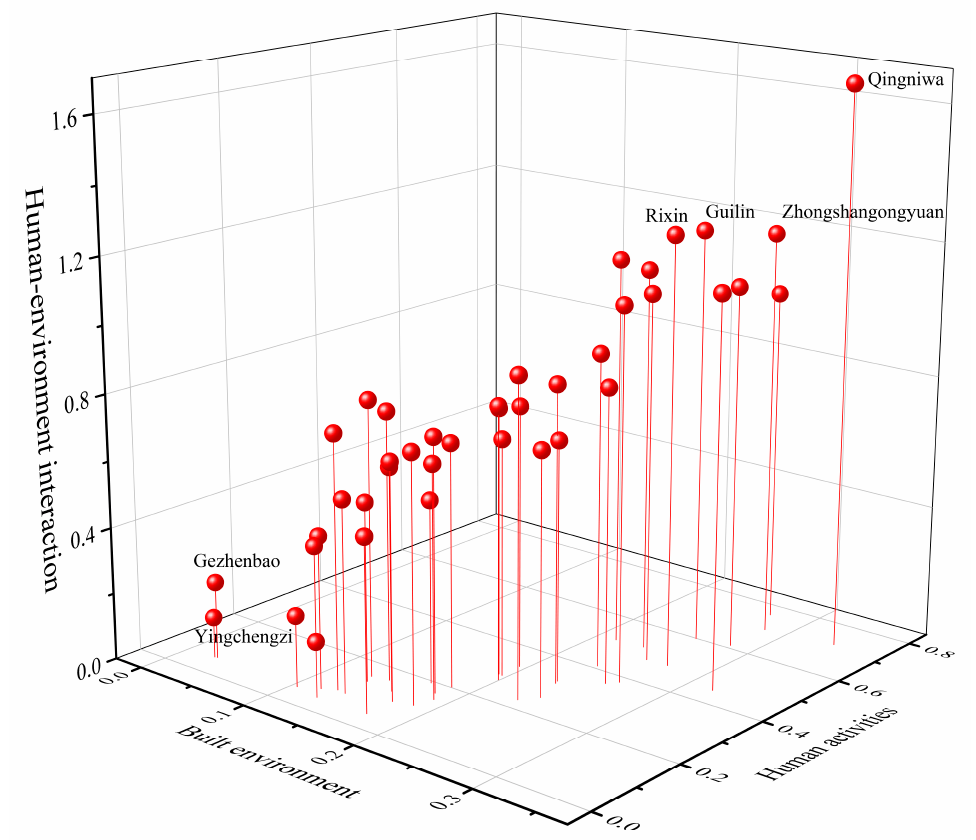
Figure 4. Three-dimensional scatter diagram of urban human settlements